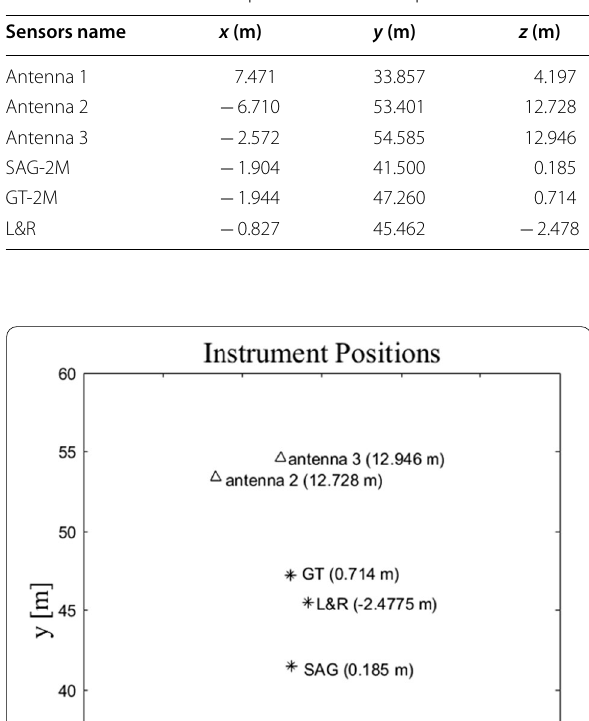
Table 2 Sensors and their position on the ship